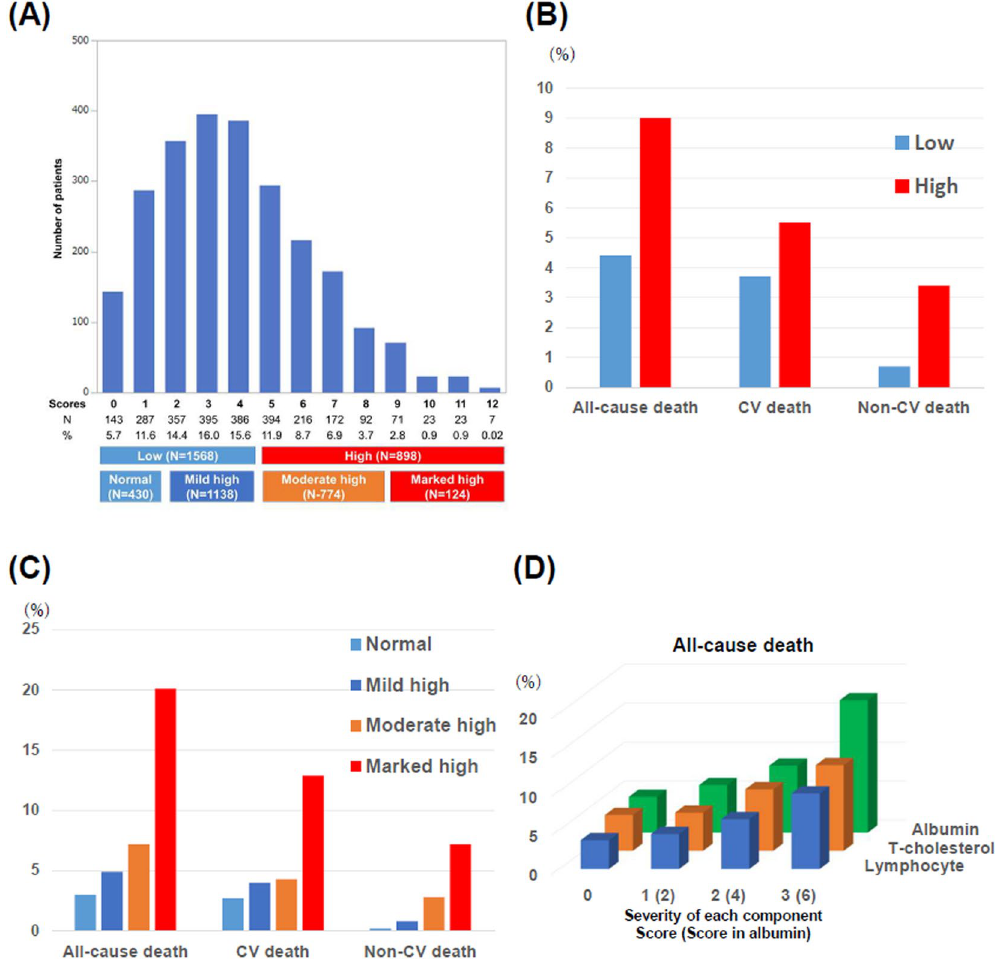
( B ) Crude incidence of all-cause, cardiovascular, and non-cardiovascular deaths in the low and high CONUT score groups. CV = cardiovascular. ( C ) Crude incidence of all-cause, cardiovascular, and non-cardiovascular deaths when classified into 4 groups: normal, mild high, moderate high, and marked high groups. ( D ) Crude incidence of all-cause according to the severity of each component of CONUT score. T-Cholesterol = Total